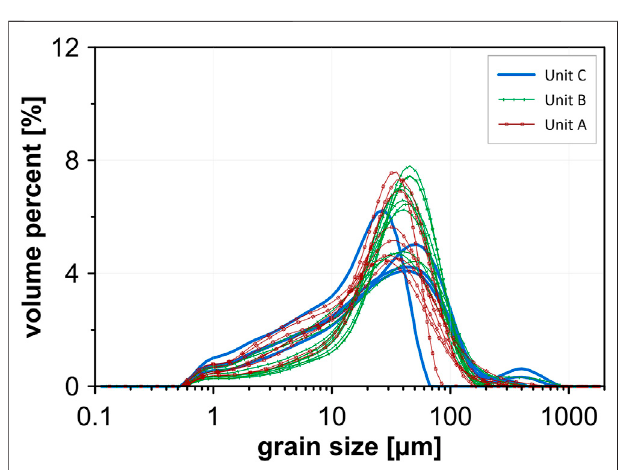
FIGURE7| GrainsizedistributionontheDuvannyYar sediments. UnitA and Unit B – late Pleistocene Yedoma, Unit C – Holocene Cover Layer.